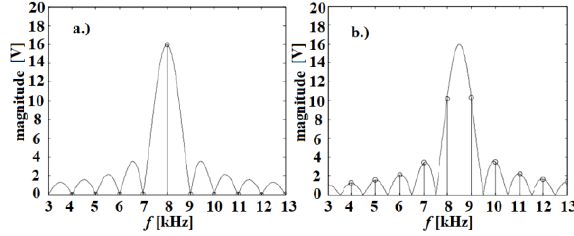
Fig. 1. The example of the convolution of spectrum of sinusoidal signal with frequency a.) 8 kHz or b.) 8.5 kHz and spectrum of rectangular measurement window with length 1 ms, where in case b.) measuring window is not total multiple of the period of sinusoidal signal - "spectrum leakage" [4]